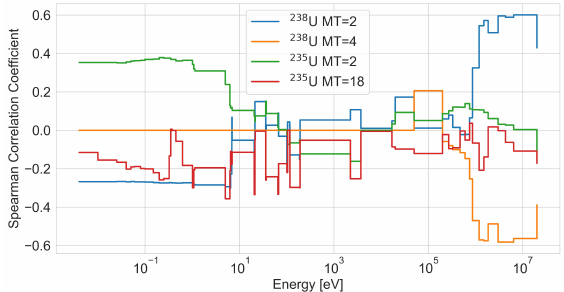
Figure 38. Statistically significant cross-sections Spearman correlation coefficients for the Bu max .